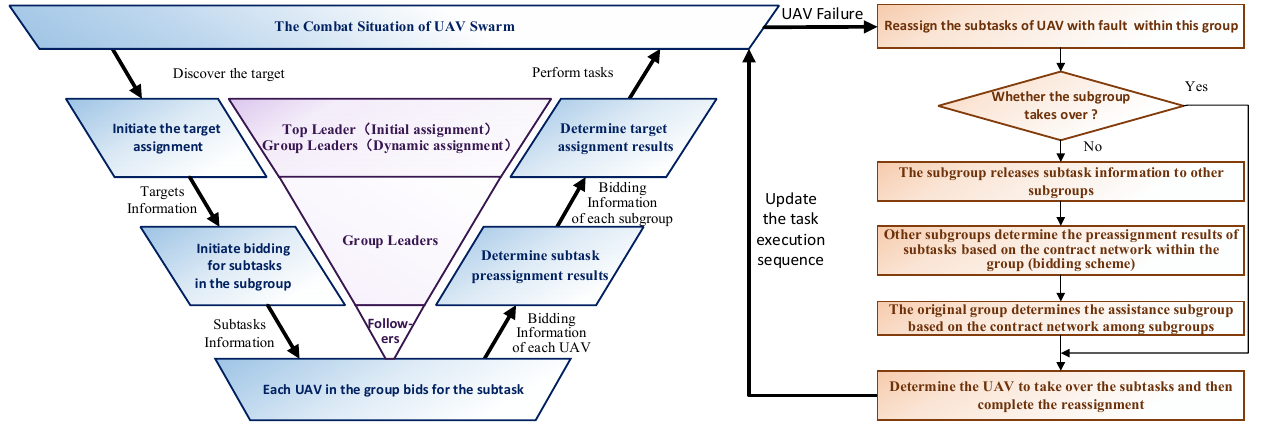
Figure 7. The procedure for cooperative dynamic task assignment.